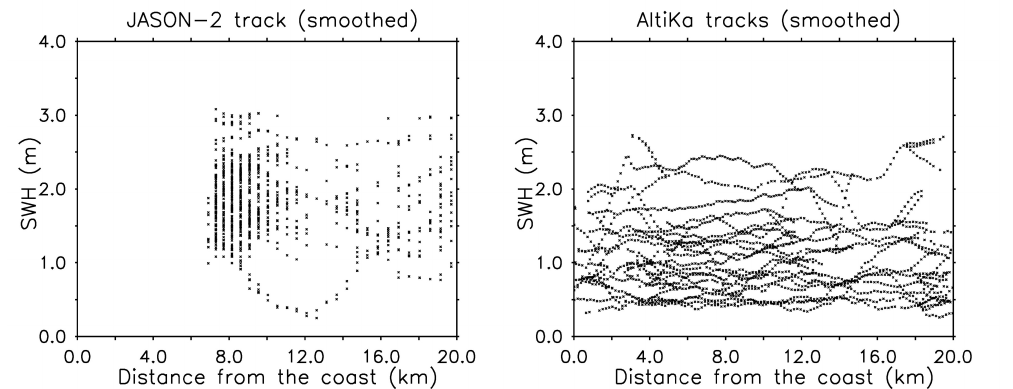
Figure 15. SWH from Jason-2 PISTACH product ( left ) and SAC coastal product ( right ) based on AltiKa